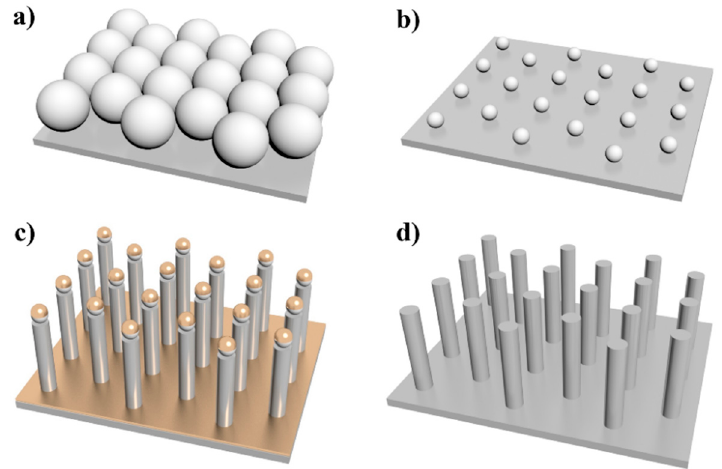
Figure 1. Schematic illustration of the SiNRs fabrication process. ( a ) Close-packed monolayer of PS nanospheres on Si wafer; ( b ) small PS array by reactive ion etching; ( c ) Au deposition and metal-assisted chemical etching into SiNRs; ( d ) remove Au.